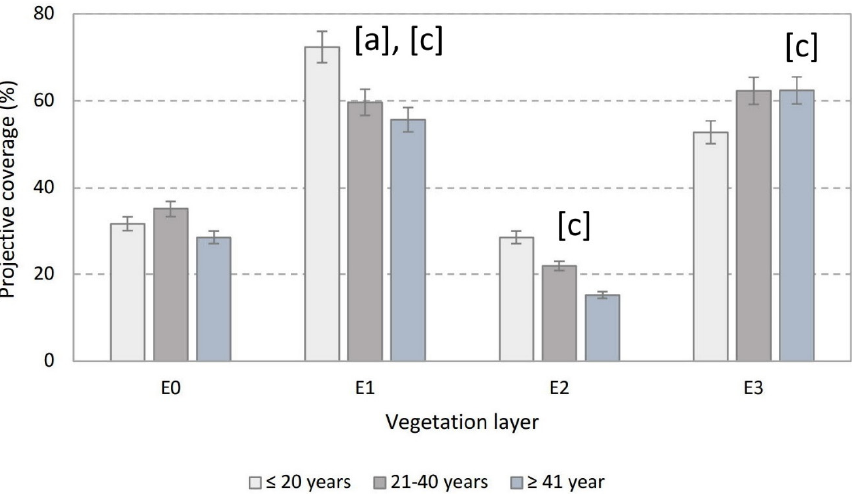
Figure 2. Projective coverage (%) of species by vegetation layer (E0 — bryophyte layer, E1 — herbaceous layer, E2 — shrub layer and E3 — tree layer) in young ( ≤ 20 years, medium-old (21 – 40 years) and old (>41 years) edges. Significant differences shown with letters: ( a ) — between young and medium old edges, ( b ) — between medium-old and old edges and ( c ) — between young and old edges ( p < 0.05). n = 90, values are means ± standard error is shown.